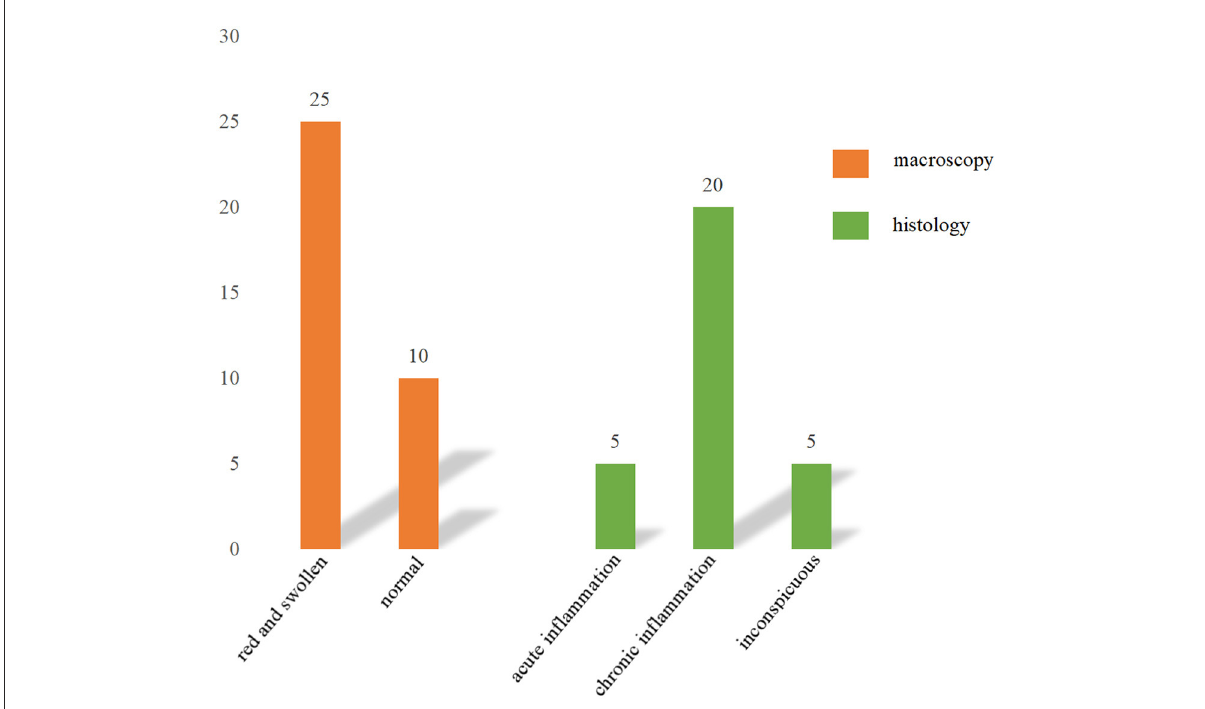
FIGURE1 Intraoperative macroscopy and histology of the appendixes.